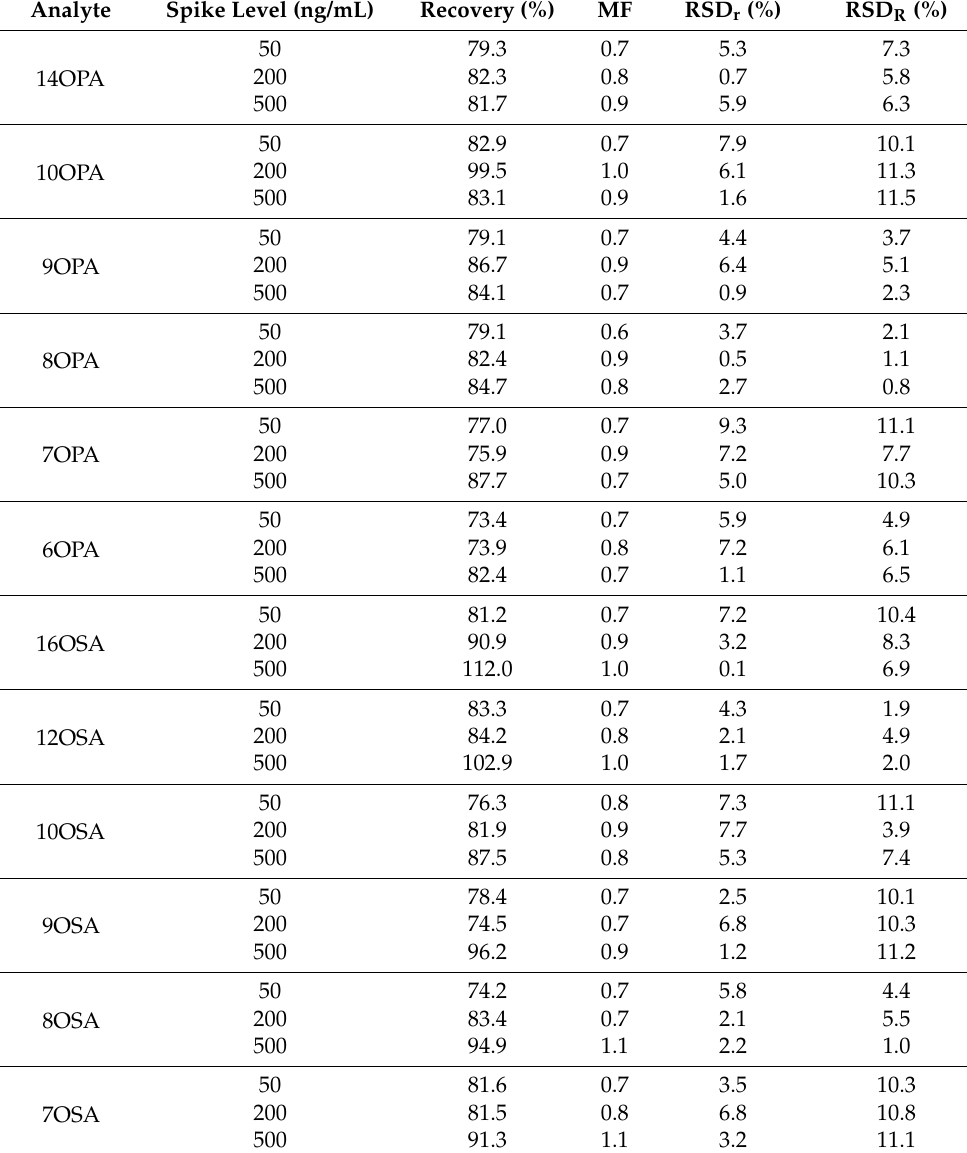
Table 3. Accuracy (recovery %), matrix factor (MF) values and precision data (RSD, %) in spiked milk